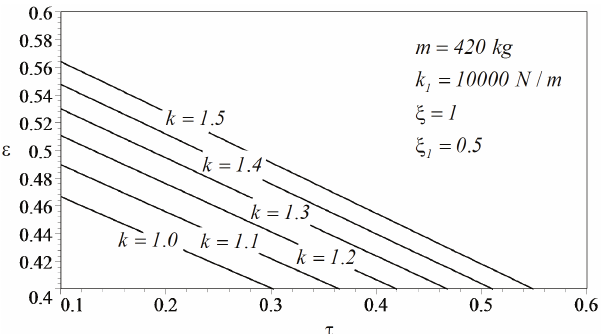
Figure 5. " versus (cid:28) , for different k for (cid:24) 1 D 0:5 to have near flat ride with ideal nonlinear damping.